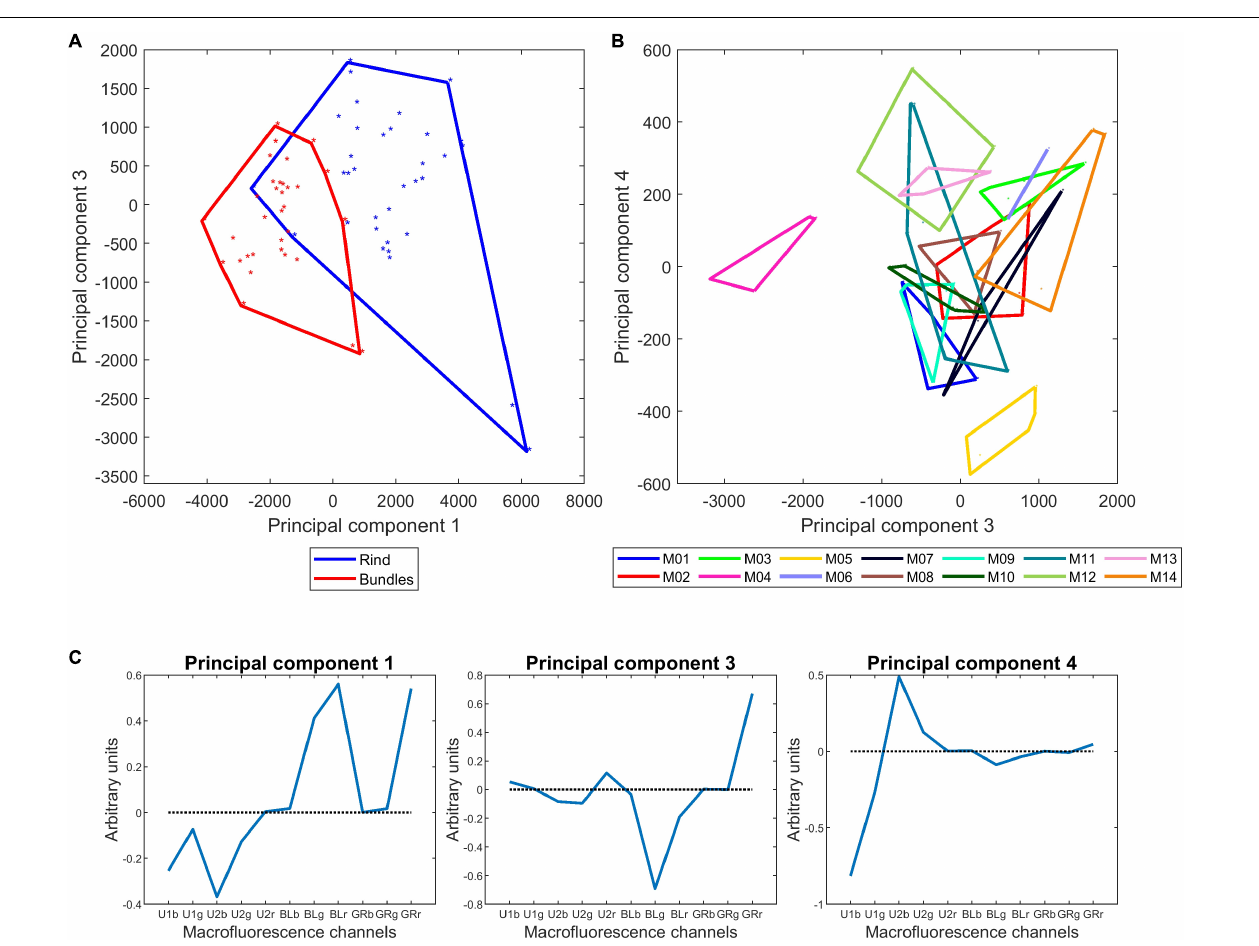
FIGURE 9 | Macrofluorescence analysis of the rinds and vascular bundles of 14 inbred lines: principal component analysis. (A,B) Sample similarity maps of components 1–3 (72 and 11% of the total variance) according to tissues and 3 and 4 according to inbred lines (11 and 1% of the total variance). (C) Loadings 1, 3, and 4. The similarity map 1–3 reveals the strong variability between rind and vascular bundles. The significant variability between inbred lines based on their fluorescence properties is observed in the similarity map 3 and 4.